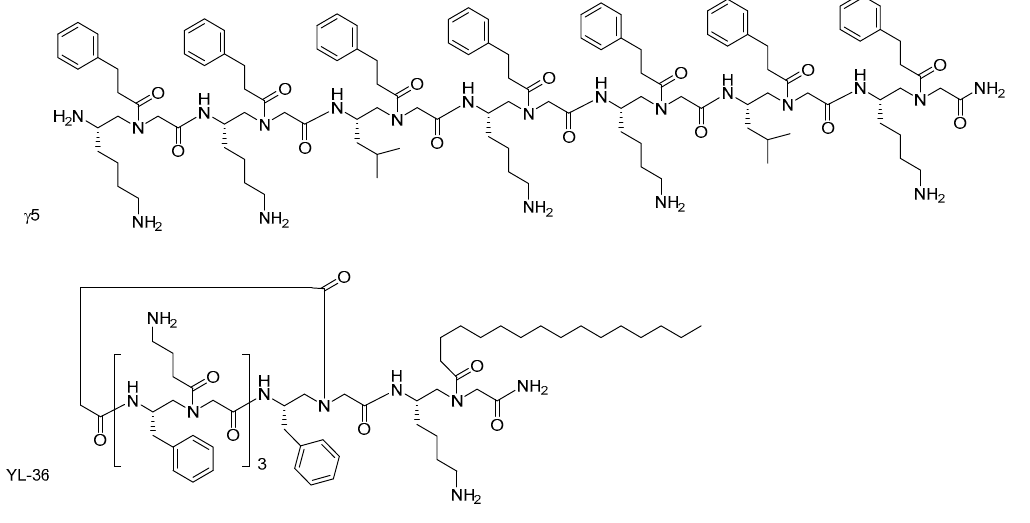
Figure 13. Most active compounds found in the studies by Niu [253] and Li [258]. Table 8. Antimicrobial and hemolytic activity of selected AApeptides (in µg/mL ). MIC Hemolysis MIC Compound type ID